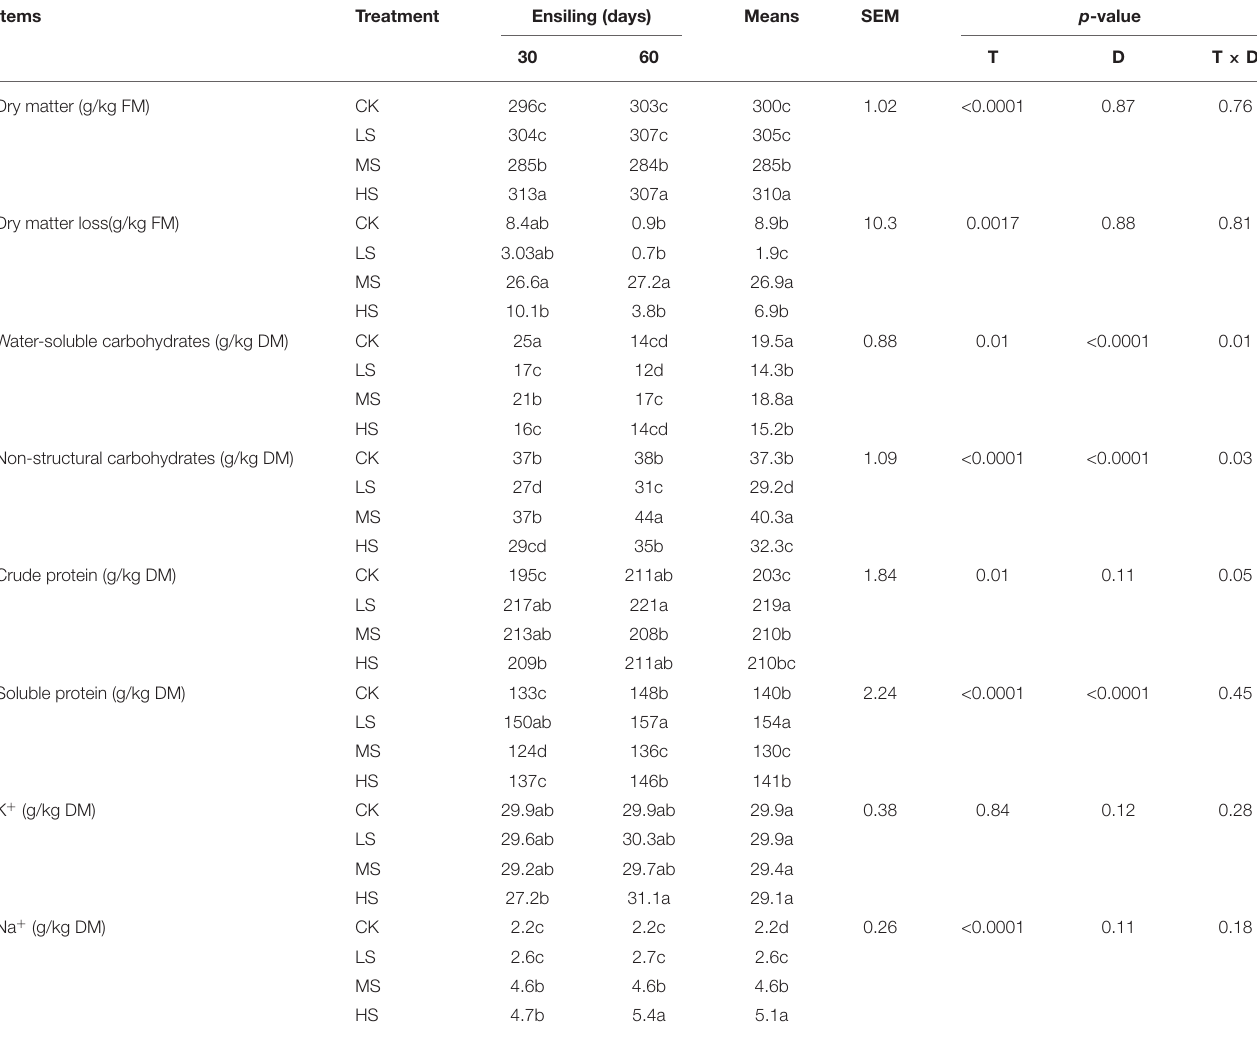
TABLE 4 | Chemical composition of alfalfa silage after 30 and 60 days of ensiling. Items Treatment Ensiling